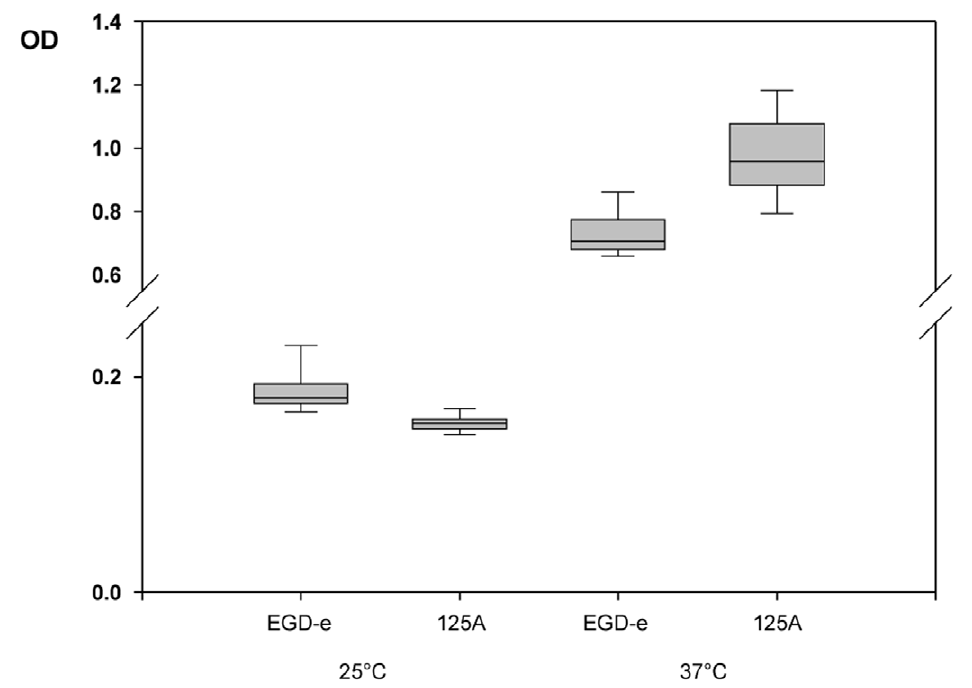
Figure 7. Biofilm formation after 16 h of incubation at 25 6 C and 37 6 C. The cells in biofilms were stained with cristal violet and measured using OD590. The values are medians of three independent experiments including 5 replicates per experiment. Bars represent standard deviations. The box limits represent the 5th and 95th percentiles.